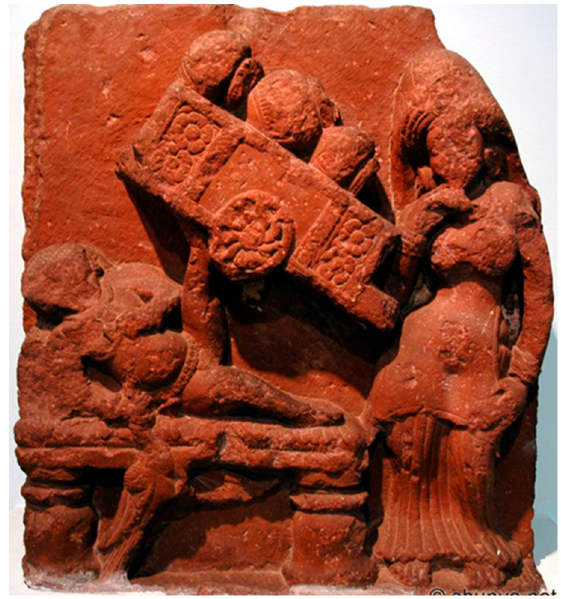
Figure 5. The Episode of the Cart and P ū tan ā . Fifth–sixth century. Deogarh, Madhya Pradesh. National Museum, Delhi.